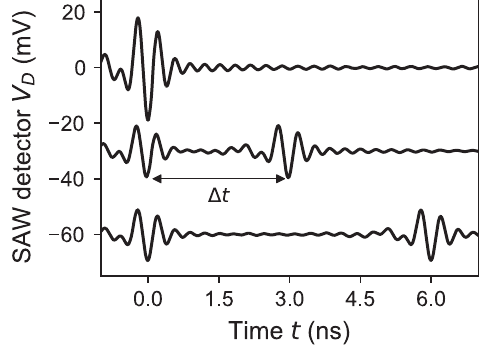
FIG. 6. Acousto-electric wave engineering. Time-resolved measurements from the SAW detector for an input